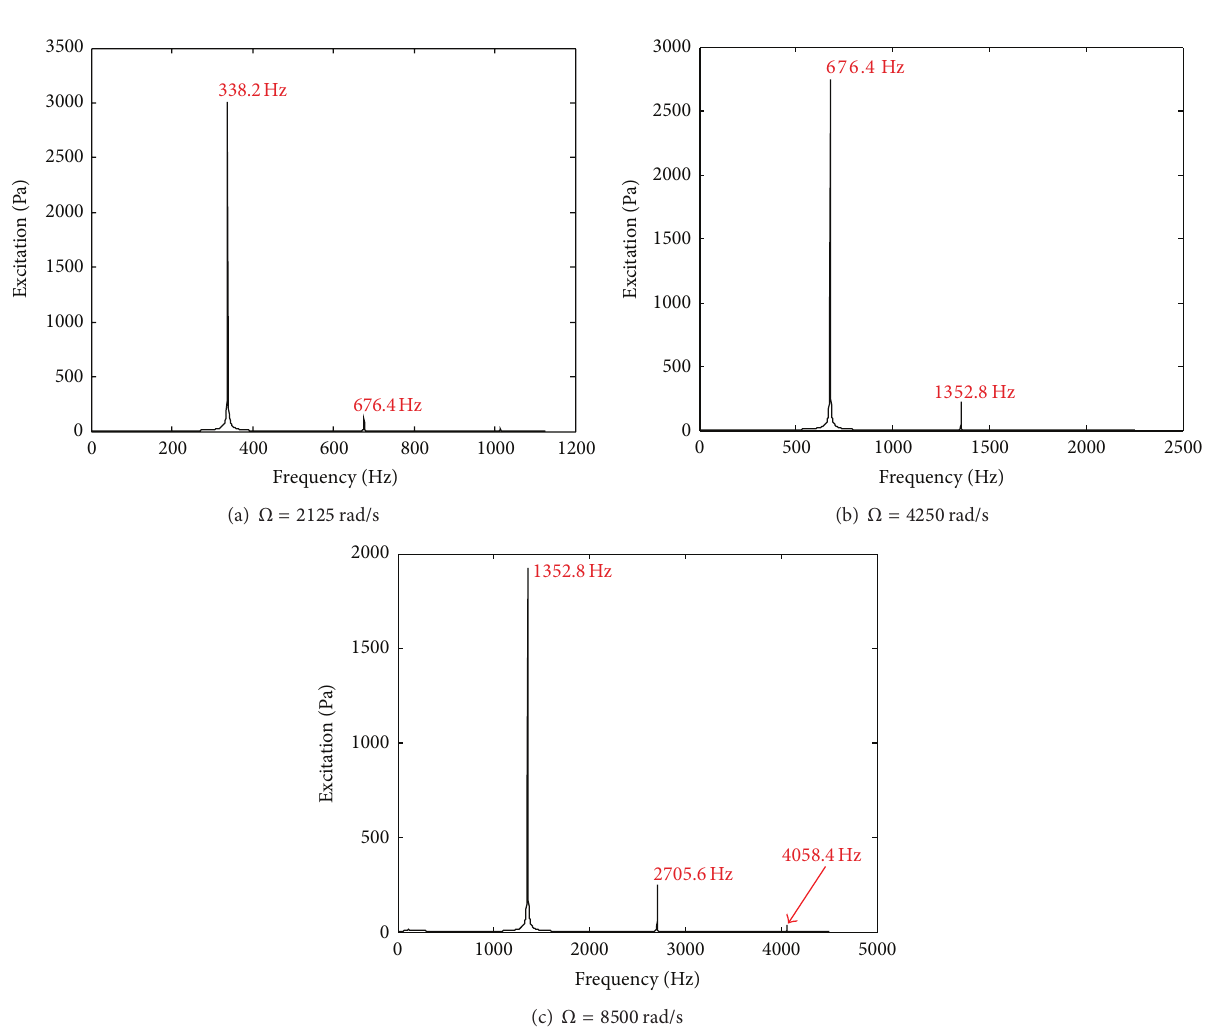
Figure 16: Calculation results of point D in different rotor whirling